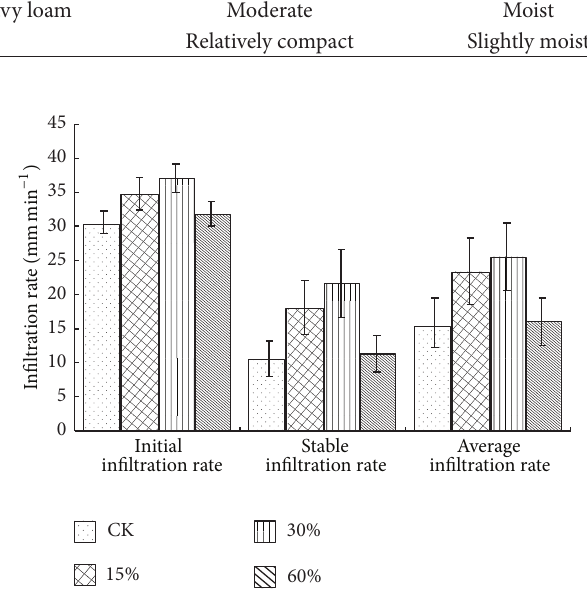
Figure 2: Soil infiltration rates of different thinning intensities.